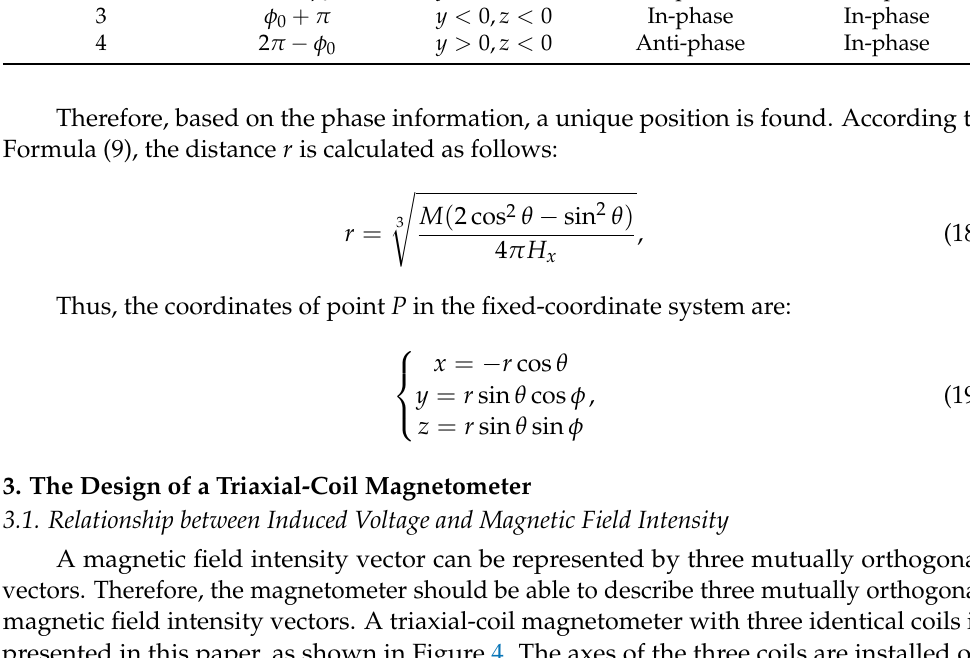
. . . H x , H y and H z . H  , H  . H  and x z y Phase between Phase between . . . . H x and H y H x and H